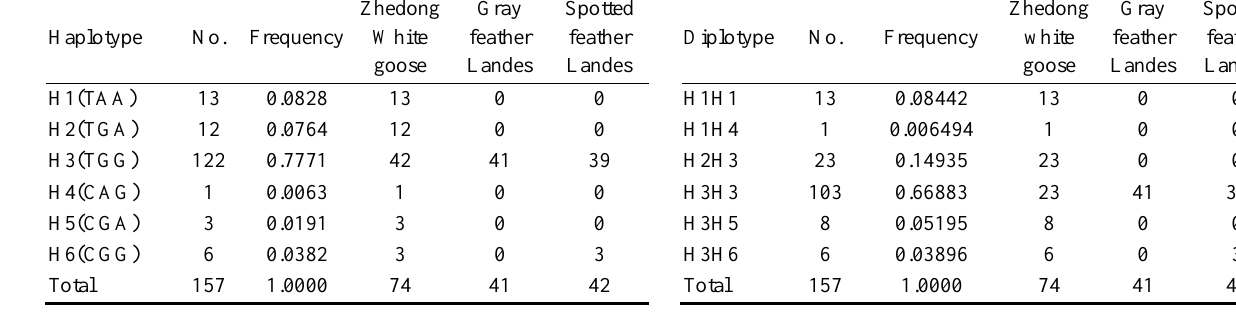
Table 4. Distribution of the TYR gene haplotypes in three goose populations Haplotype